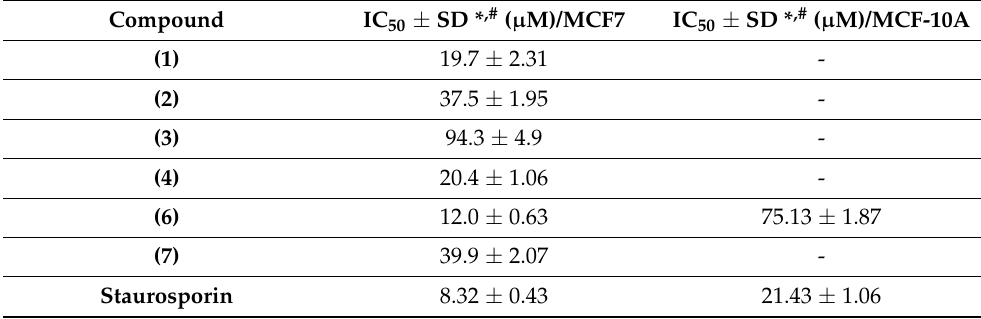
Table 2. IC 50 values of the tested compounds against MCF-7 lines using the MTT